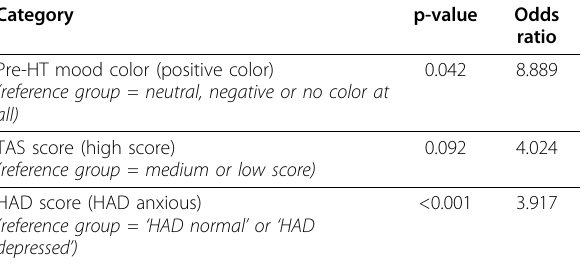
Table 9 Logistic regression assessing the relationship between response to treatment and pre-HT mood color, TAS and HAD scores